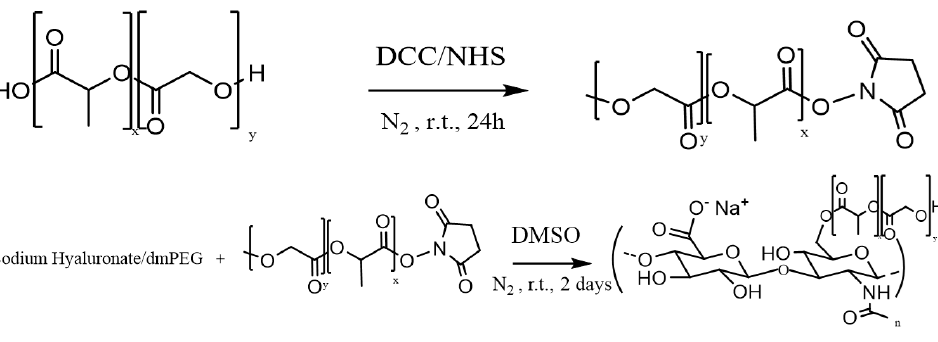
Figure 1. Schematic synthesis for PLGA-HA polymer.